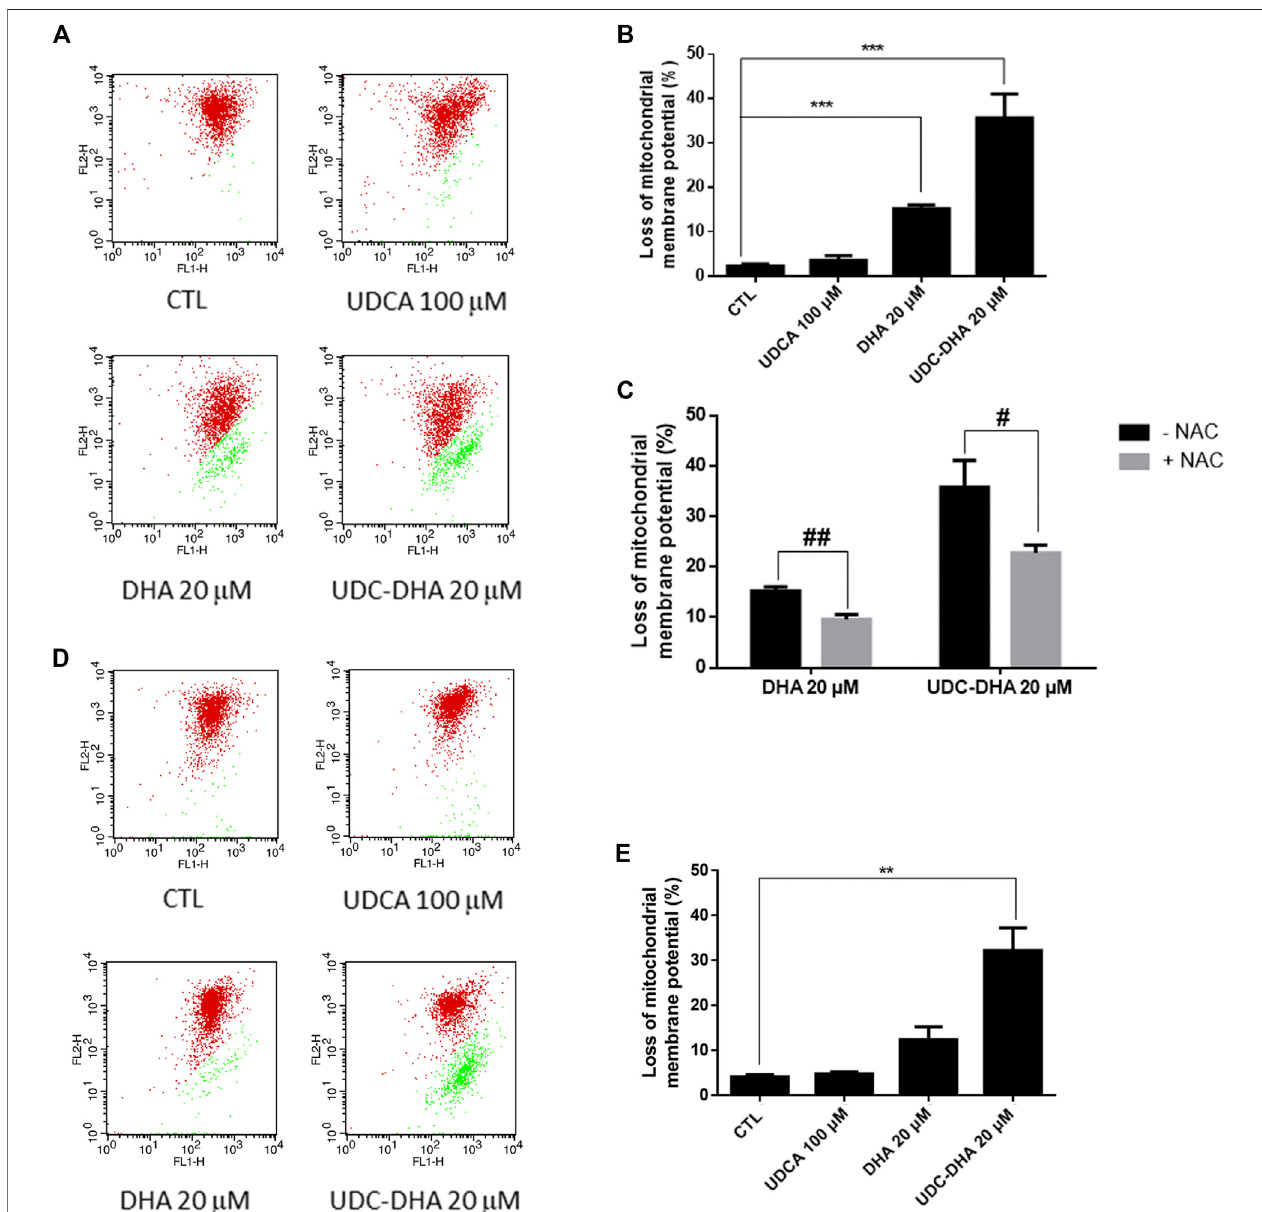
FIGURE5| DHAand UDC-DHA induce MMP loss inHCC cells. (A) Dotplots ofMMP loss induced byDHA,UDCA and UDC-DHA inHepG2 cells. (B) Quantitative data of MMP loss induced by DHA, UDCA and UDC-DHA in HepG2 cells. (C) NAC cotreatment reversed the depolarization of MMP induced by DHA and UDC-DHA in HepG2cells. (D) DotplotsofMMPlossinducedbyDHA,UDCAandUDC-DHAinHuh-7cells. (E) QuantitativedataofMMPlossinducedbyDHA,UDCAandUDC-DHA in Huh-7 cells. HCC cells were treated with indicated concentrations of DHA, UDCA and UDC-DHA for 48 h with or without 2 mM NAC. JC-1 dye (5 μ g/ml) was addedtothecells30 minbeforeterminationofthetreatment period.Cellswereharvested for fl owcytometricanalysisofJC-1 fl uorescence.Thepercentage ofcellswith depolarizationofMMP(labeledingreen)wasanalyzedbyCellQuestsoftware.Dataarepresentedasmean ± SEMofatleastthreeindependentexperiments.**, p < 0.01; ***, p < 0.001 vs. the control group. #, p < 0.05; ##, p < 0.01 vs. respective non-NAC treatment